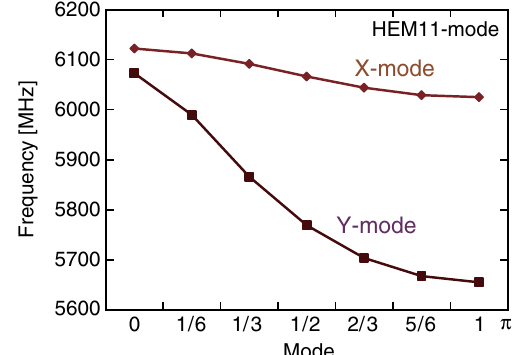
FIG. 28. Measured dispersion relations of the X and Y HEM-11